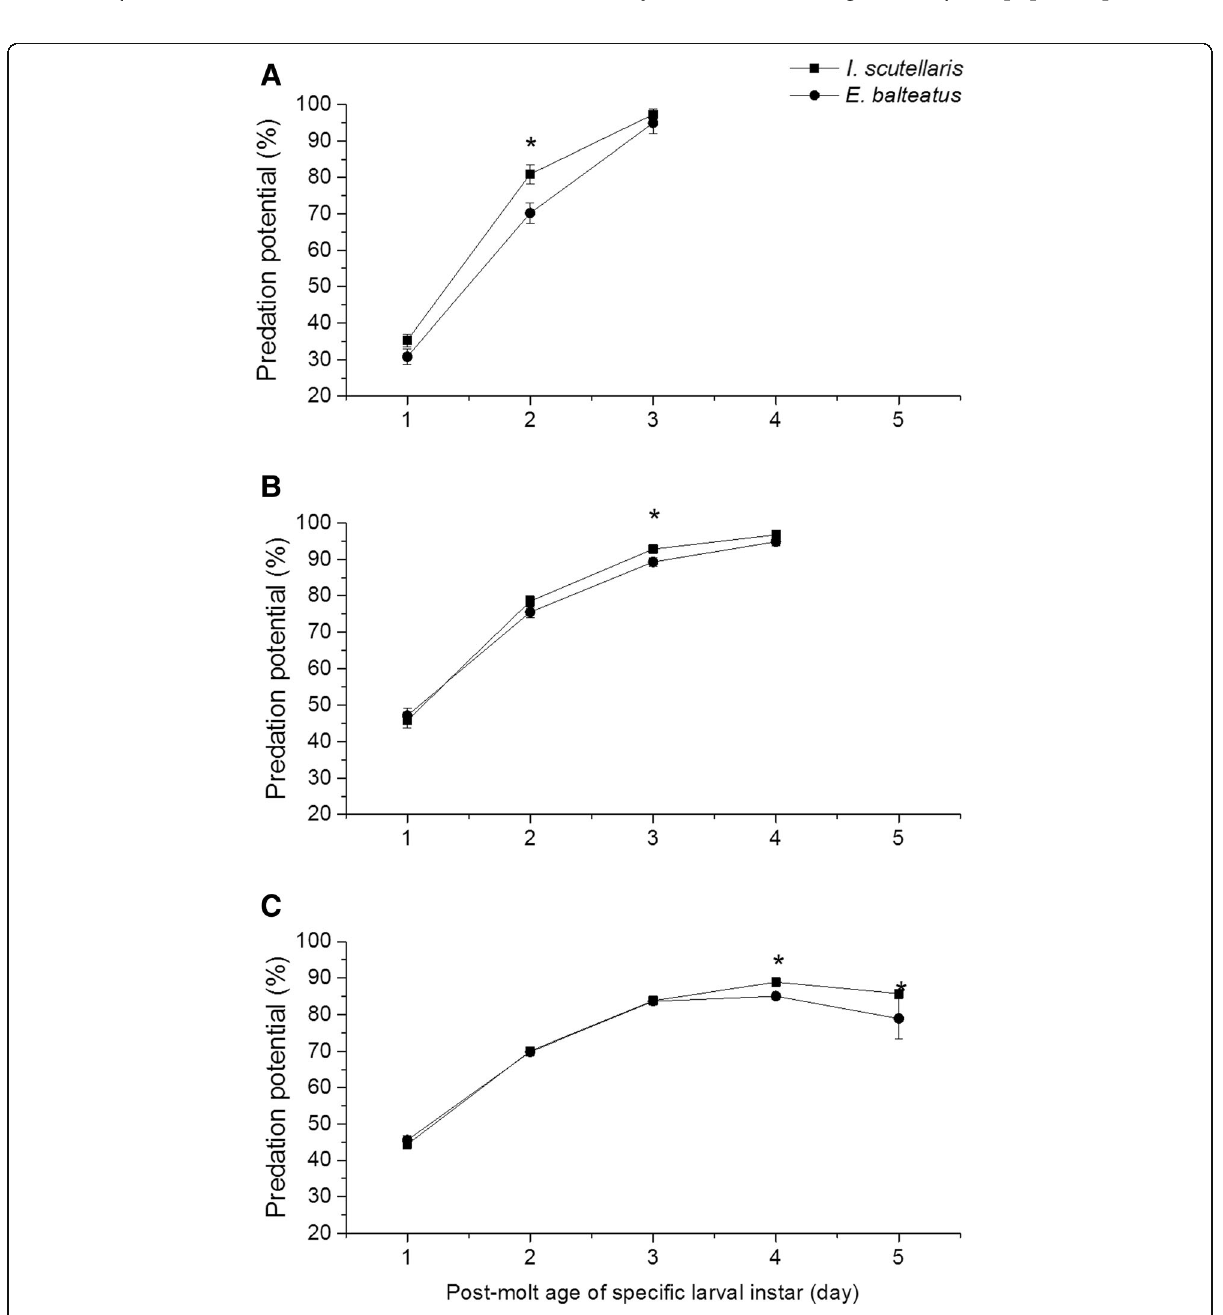
Fig. 5 Daily prey-consumption rate of 1st ( a ), 2nd ( b ), and 3rd ( c ) instar larvae of I. scutellaris and E. balteatus . The data points presented are means± SEM. The data points where the SEM overlaps are not statistically different from one another ( P <